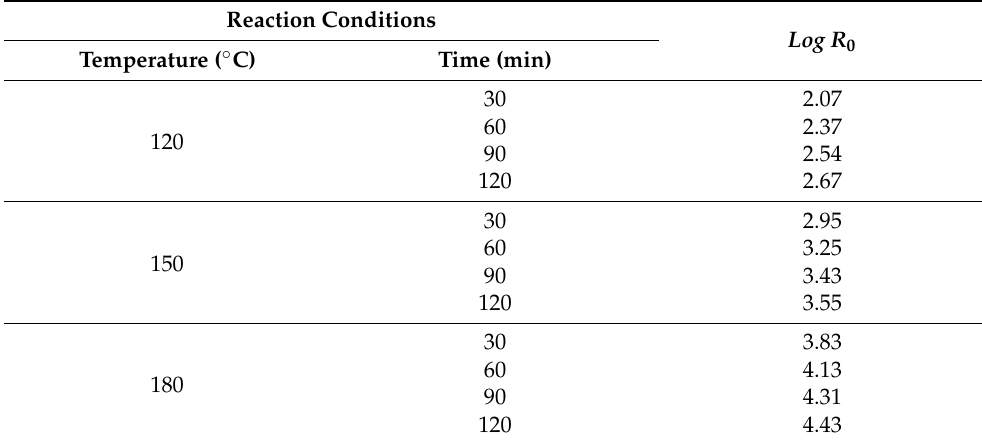
Table 1. Reaction severities ( Log R 0 ) vs. reaction temperatures and times. Reaction